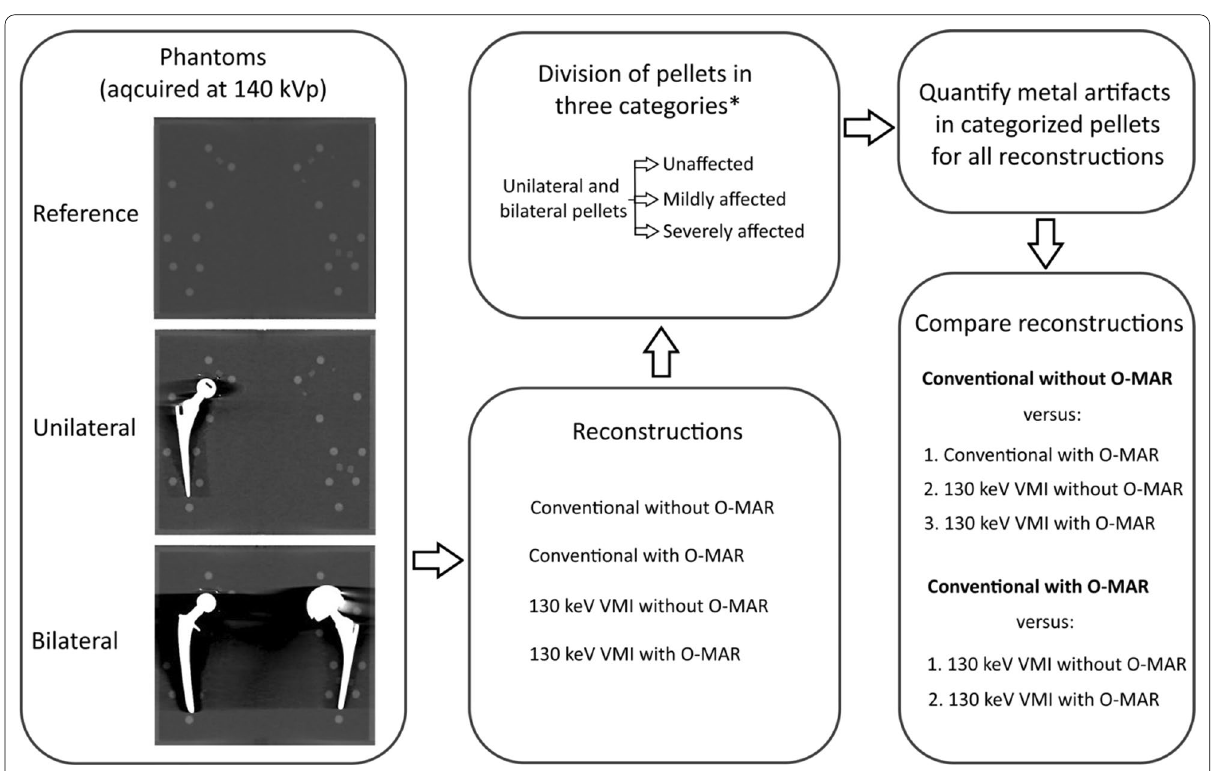
Fig. 3 Study design. *Categorization of pellets was based on the conventional reference image without O-MAR